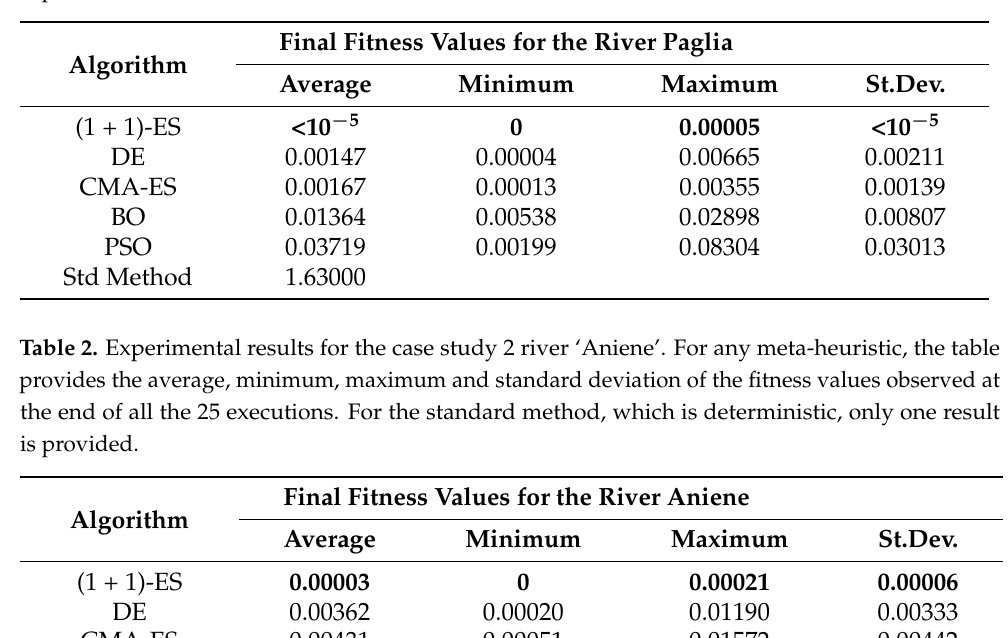
Table 1. Experimental results for the case study 1 river ‘Paglia’. For any meta-heuristic, the table provides the average, minimum, maximum and standard deviation of the fitness values observed at the end of all the 25 executions. For the standard method, which is deterministic, only one result is provided.